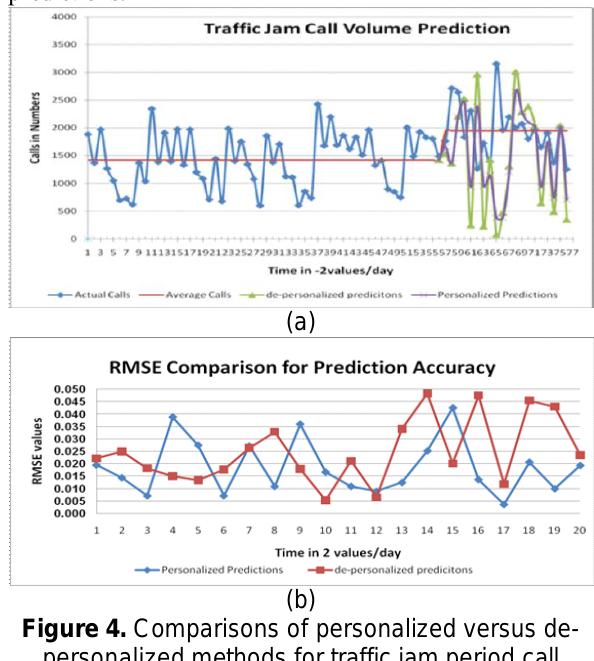
Figure 4. Comparisons of personalized versus de- personalized methods for traffic jam period call prediction, (a) call volume predictions and (b) root mean square error